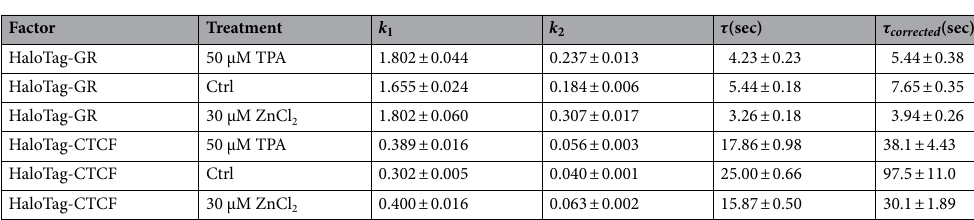
Table 2. Photobleaching-corrected 2D dwell time fits for HaloTag-GR and HaloTag-CTCF. k 1 and k 2 are the rate constants for the fast and slow components, respectively. τ is the dwell time calculated using k 2 , and τ corrected is the photobleaching corrected dwell time calculated using H2B dwell times calculated at the same frame